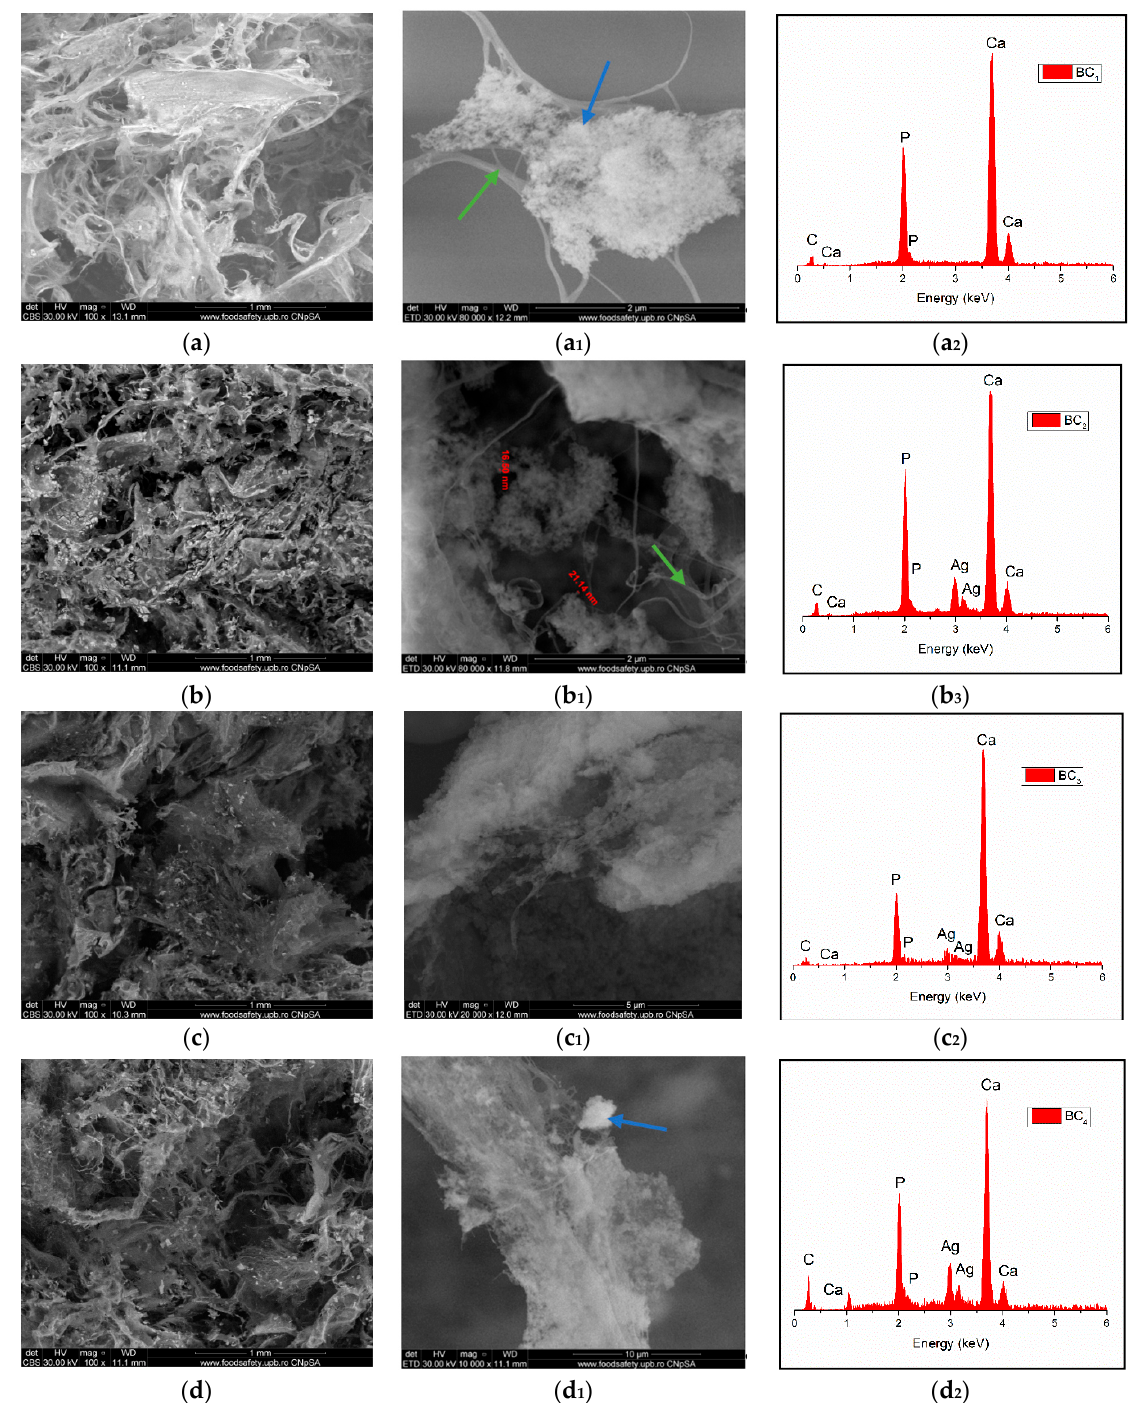
Figure 7. High-resolution backscattered-electron (BSE) images (and EDS spectra at 100× magnification for: BC 1 ( a , a 1 , a 2 ), BC 2 ( b , b 1 , b 2 ), BC 3 ( c , c 1 , c 2 ), BC 4 ( d , d 1 , d 2 ). (where a 1 – d 1 images represent a high magnification of a-d images area; green arrow indicates the fibrous structure of BC and blue arrow indicate inorganic particles).